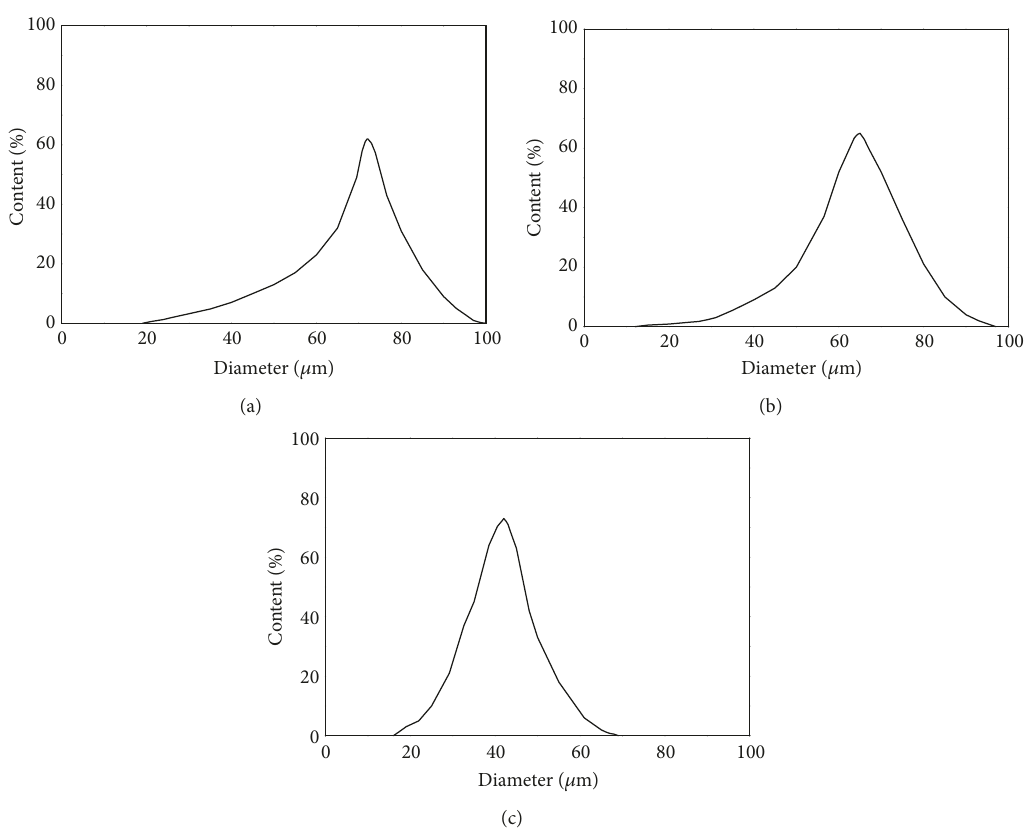
Figure 4: Particle diameter distribution curves of PP powders prepared on different conditions: (a) dissolution temperature 166 ∘ C; (b) dissolution temperature 166 ∘ C and solid-to-solvent ratio 0.067g/ml; (c) dissolution temperature 166 ∘ C, solid-to-solvent ratio 0.067g/ml, and pressure